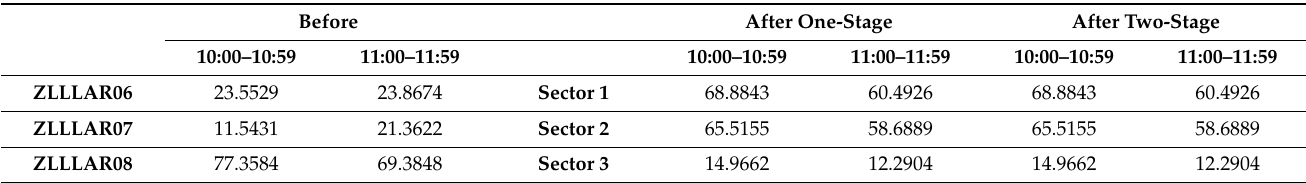
Table 7. 10:00–11:59 Workload values for each sector before and after optimization.